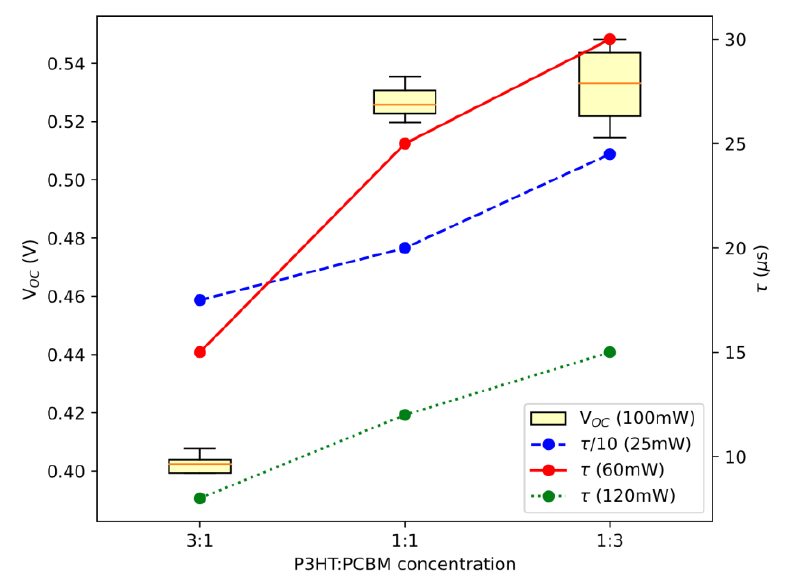
Figure 7. Boxplot of V OC as a function of P3HT:PCBM ratio, compared to charge carrier lifetime (lines) at different illumination intensity.